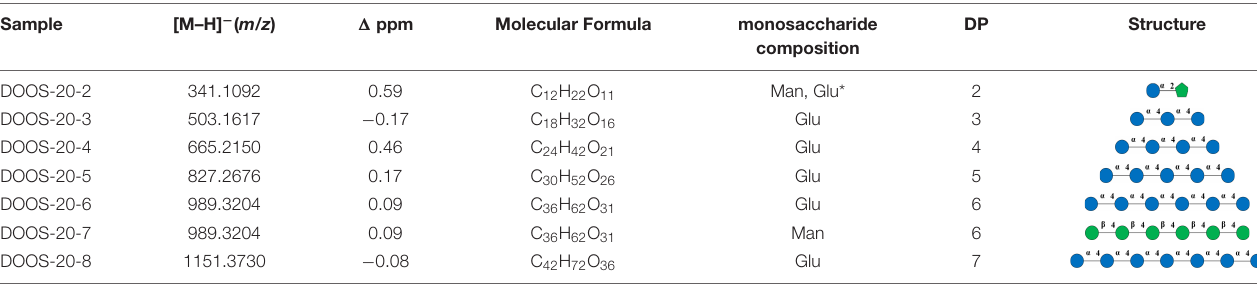
(C) Monosaccharide composition analysis of DOOS-20 purified sections. TABLE 1 | Structure identification of each purified section of DOOS-20. Sample Molecular Formula